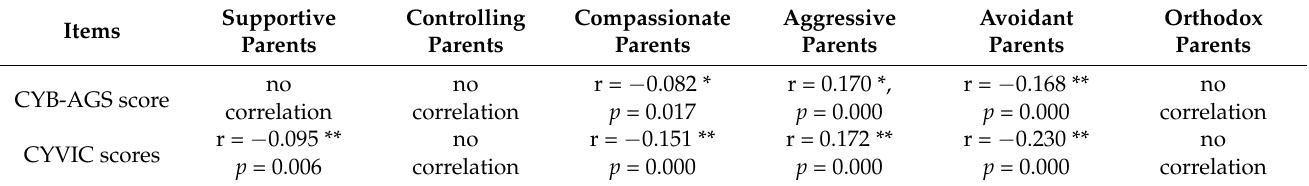
Table 6. Correlational results of PSDQ subscales and aggression and victimization scores